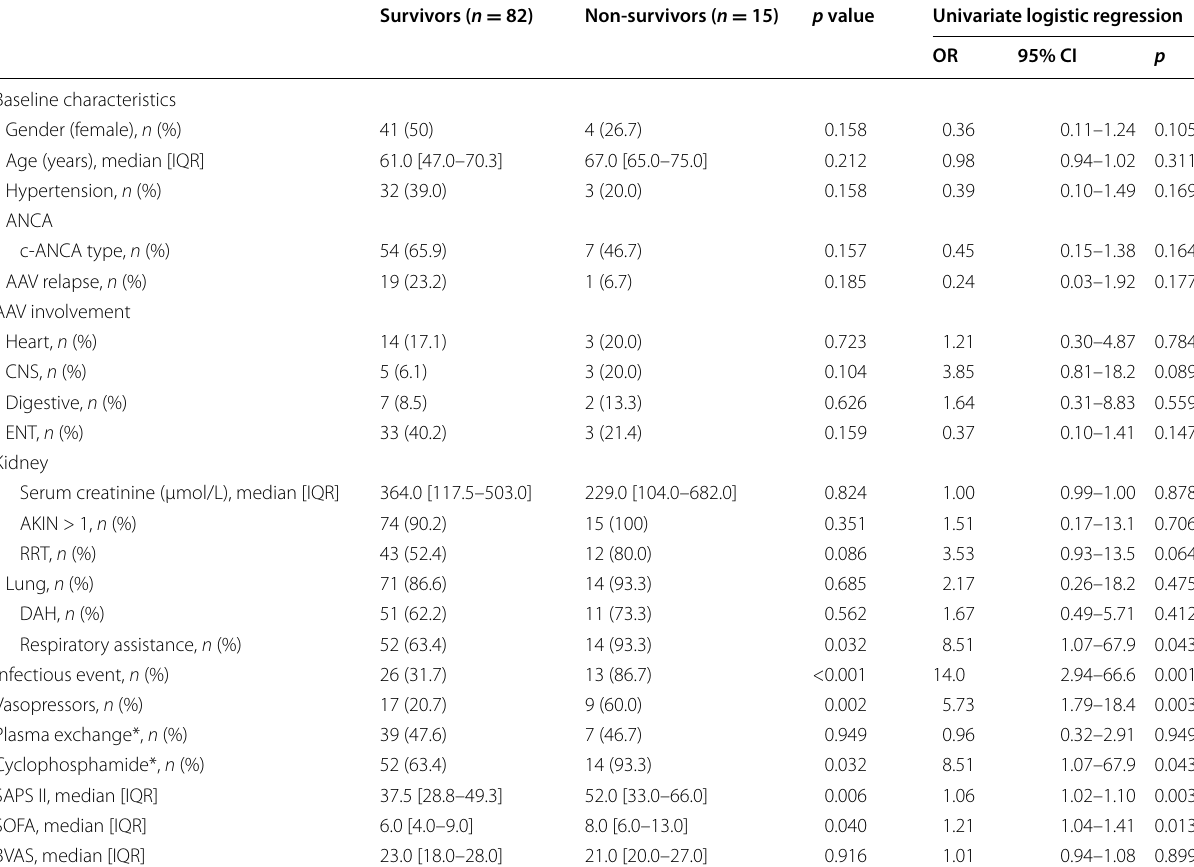
Table 3 Comparison between survivor and non-survivor ICU-AAV patients and univariate logistic regression analysis for ICU mortality